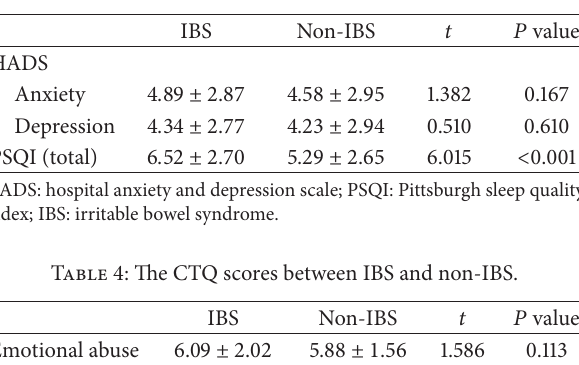
Table 3: Comparing mean scores of the HADS and PSQI between IBS and non-IBS.